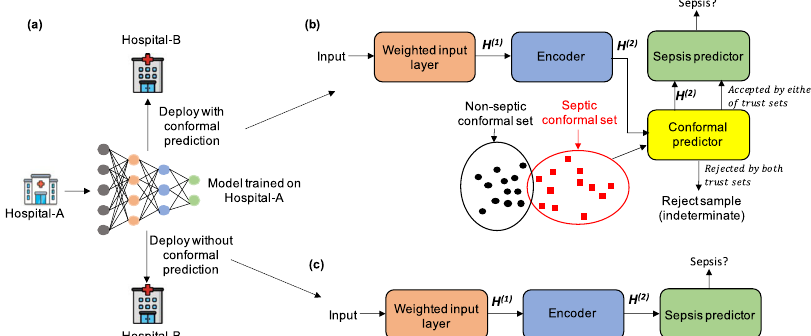
Fig. 1 Schematic diagram of COMPOSER. Two possible deployment schemes are shown in panel ( a ). During the evaluation phase of COMPOSER (panel b ), the input test data is fi rst fed into the weighted input layer, and is then passed through the encoder ( fi rst module ), after which the method of conformal prediction is utilized to determine the ‘ conditions for use ’ ( second module ). This is achieved by comparing the conformity of the new representation ( H (2) ) to the representations in the conformal set, which are carefully selected during the training phase (see Methods section). If conformity can be achieved at a given con fi dence level ( ε ), H (2) is then forwarded to the sepsis predictor to obtain a risk score ( third module ). In comparison, panel ( c ) shows a deployment scheme without the use of conformal